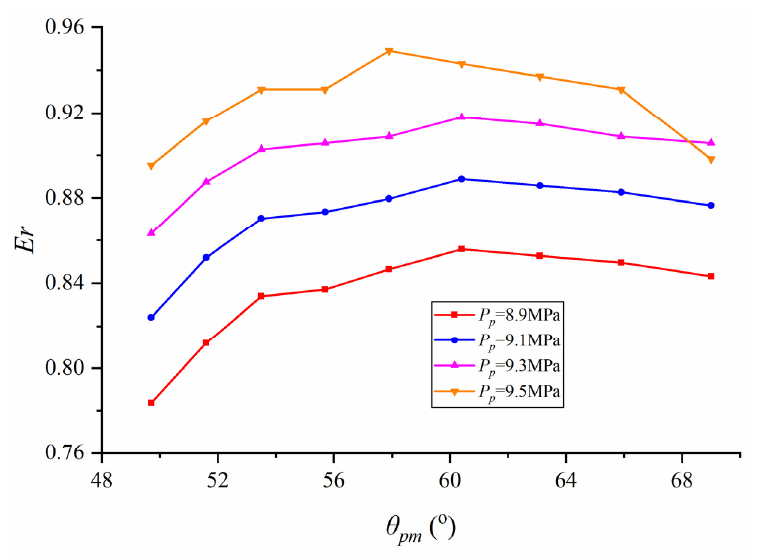
Figure 13. Variations of Er with different θ pm and P p ( D m of 8 mm, L m of 64 mm).